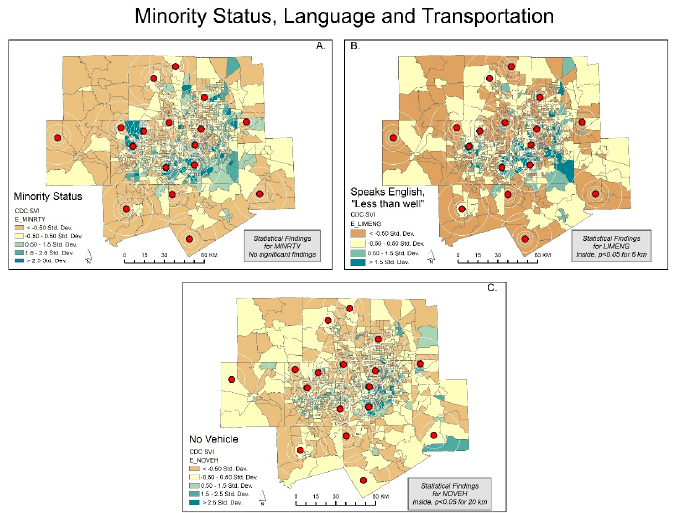
Figure 2. Dallas—Fort Worth: SD classification scheme of social variables for minority status, language and transportation. The CDC/ATSDR SVI variables include Figures; ( A ) minority status; ( B ) speaks English, “less than well”; ( C ) no vehicle.